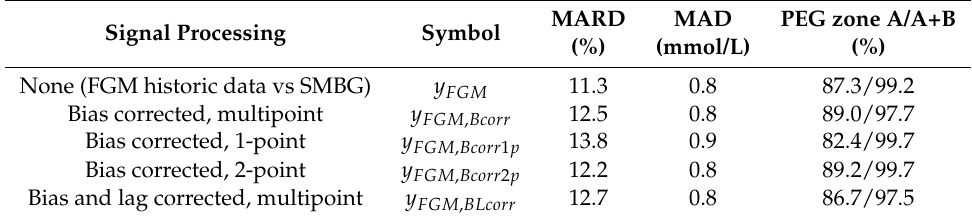
Table A1. Influence on overall MARD of different signal processing for days 2–7, using biases and lags estimated from day 1